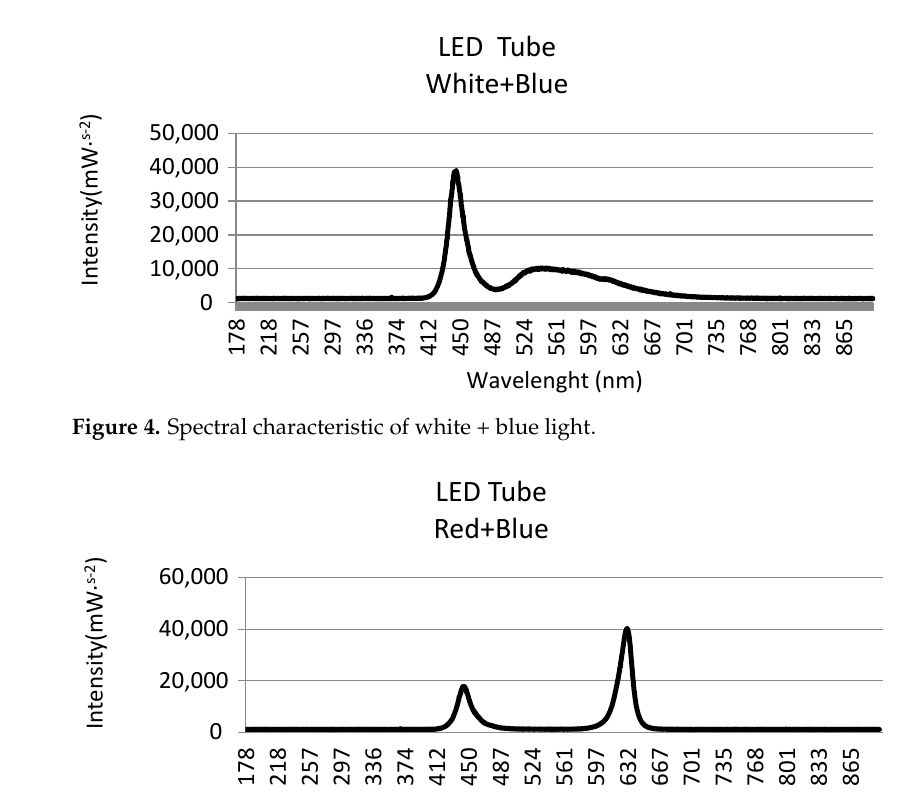
Figure 3. Spectral characteristic of blue light.